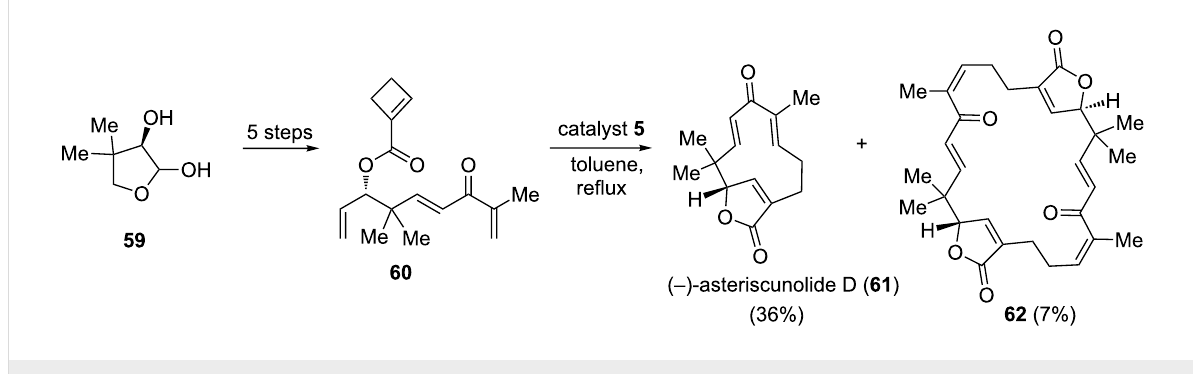
Cyclopentene systems In RRM with cyclopentene systems, the release of ring strain is a less important contributor to the driving force of the